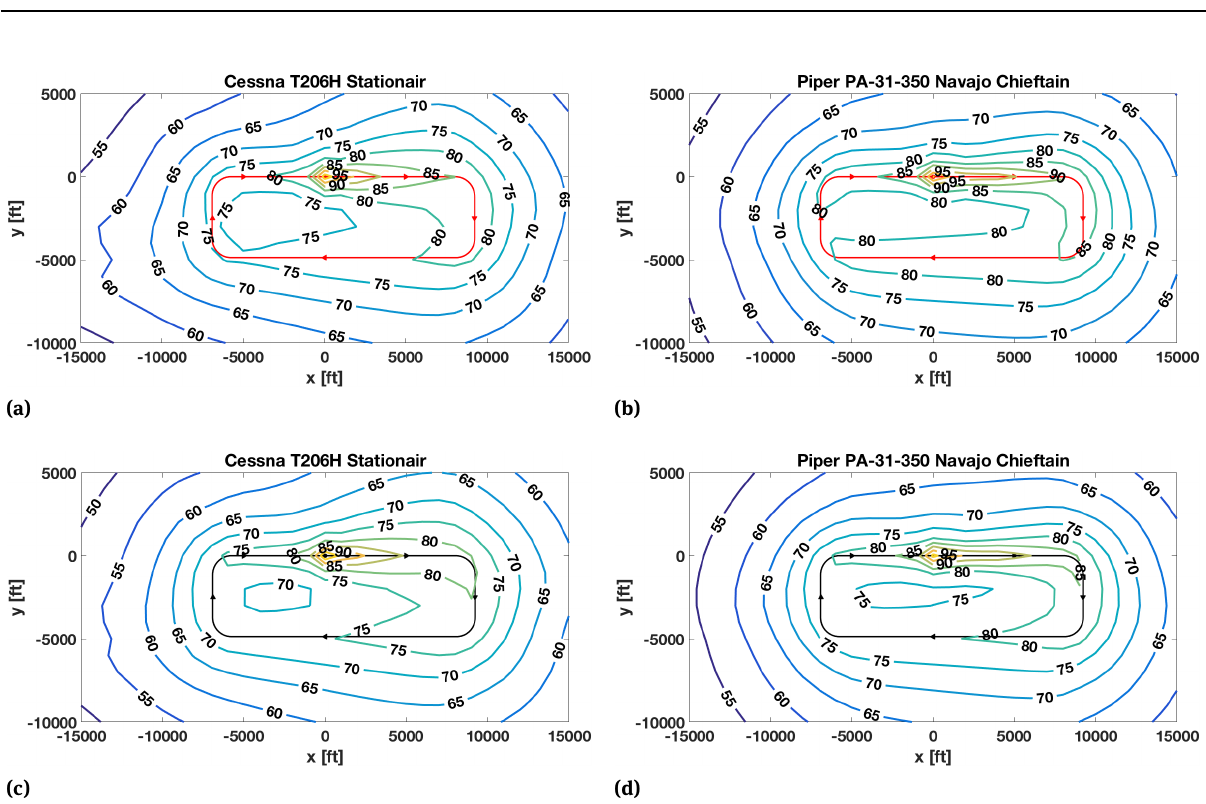
Figure 6: Contour plots of SEL over an extended sensor grid around Milan-Bresso airport. (a,b) case 1 (piston engine always active), (c,d) case 7 (piston engine always deactivated), as per Table 6. (a,c) Cessna T206H Stationair. (b,d) Piper PA-31-350 Navajo Chieftain. Values in